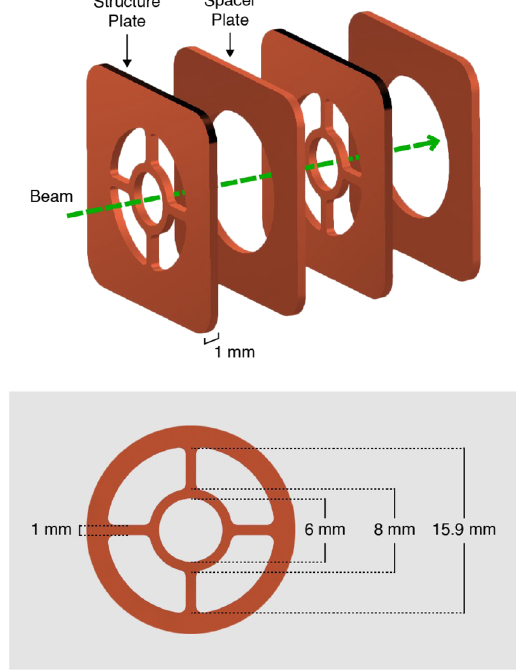
FIG. 2. Top: exploded view of two wagon wheel metamaterial unit cells. Each cell consists of a structure plate and a spacer plate, each 1 mm in thickness. A beam traversing the center of the cells will radiate backwards in reverse Cherenkov radiation. Bottom: dimensions of the wagon wheel structure plate.